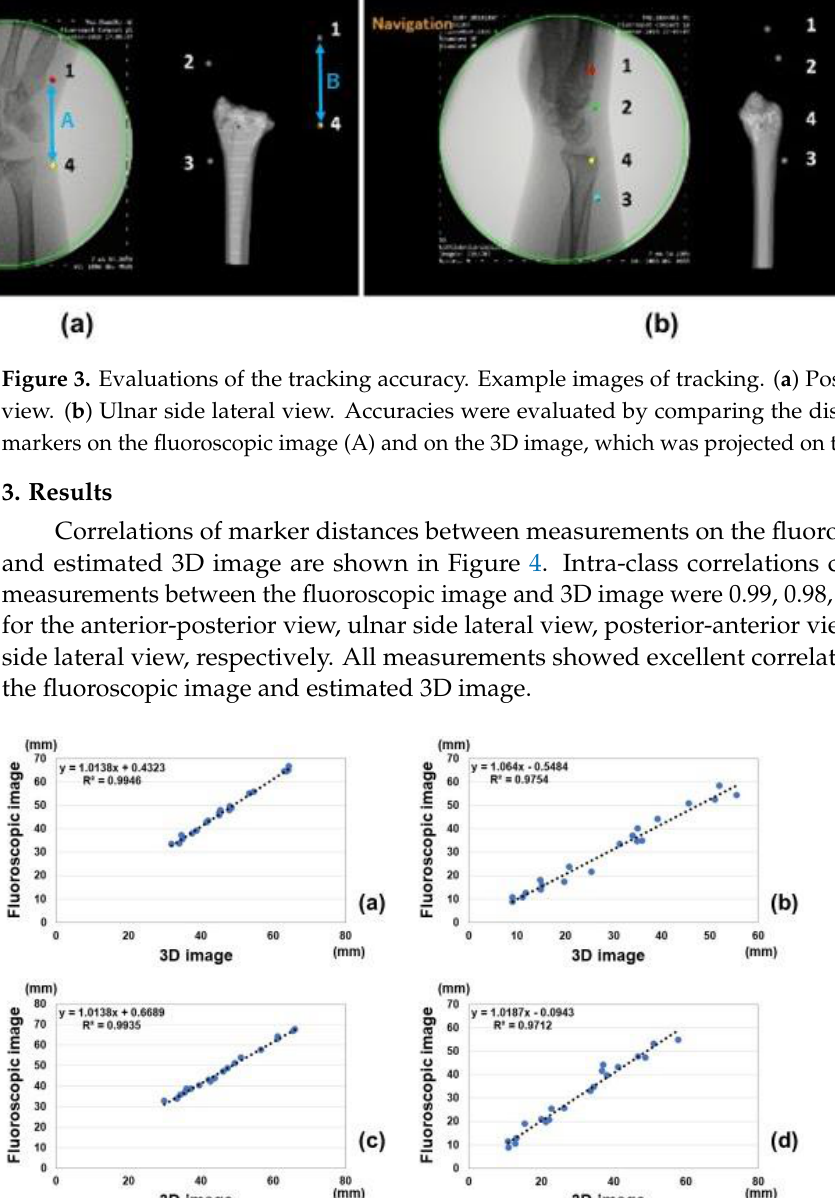
Figure 4. Correlations of marker distances between measurements on the fluoroscopic image and estimated 3D image. ( a ) Anterior-posterior view, ( b ) Ulnar side lateral view, ( c ) Posterior- anterior view, and ( d ) Radial side lateral view.